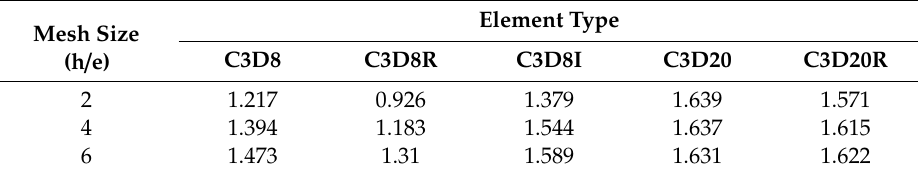
Table 2. The results of the convergence analysis.